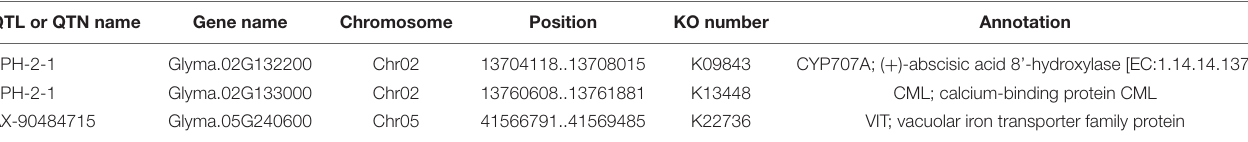
FIGURE 4 | Distribution of QTLs and QTNs for plant height identified in RIL 6013 and the germplasm panel on genome map. Bolded black fonts represent multi-environment QTL, blue fonts represent QTLs in previous studies and red fonts represent QTLs and QTNs that are used to predict candidate genes. TABLE 5 | Detailed information of three candidate genes related to plant